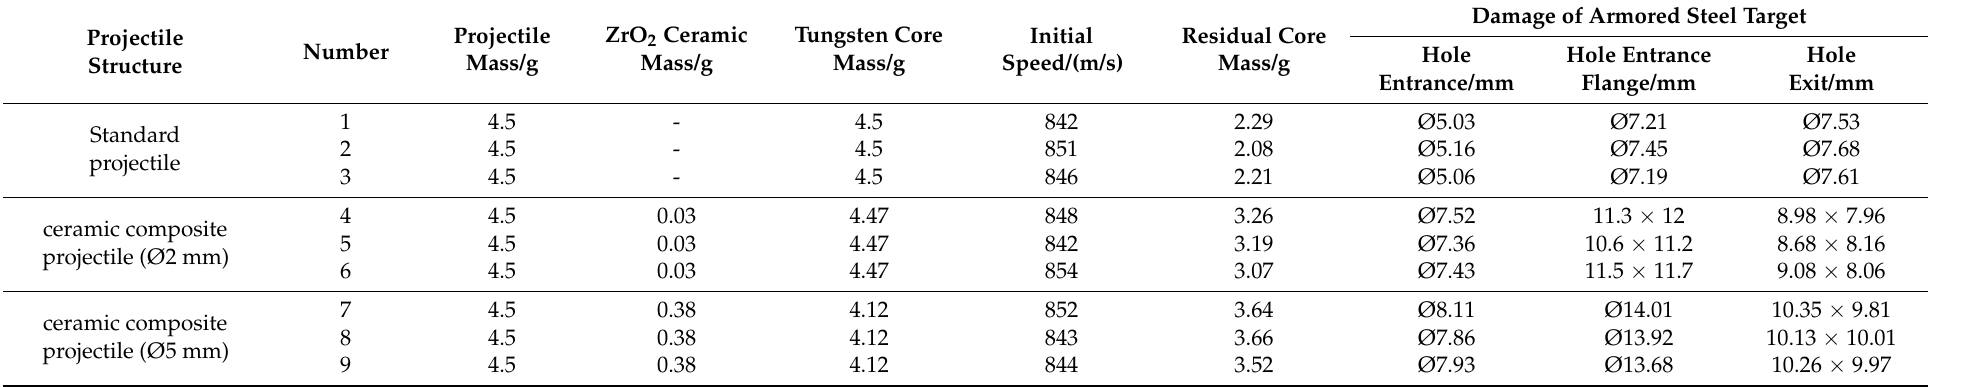
Table 2. Test data of projectiles with different structures penetrating the 10 mm armored steel